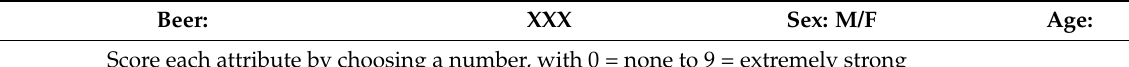
Table 2. Sample ballot given to brewery taste panels accompanying the beer for sensory analysis. Aroma attributes determined from consensus method with CATA performed by UC Davis Brewing Lab